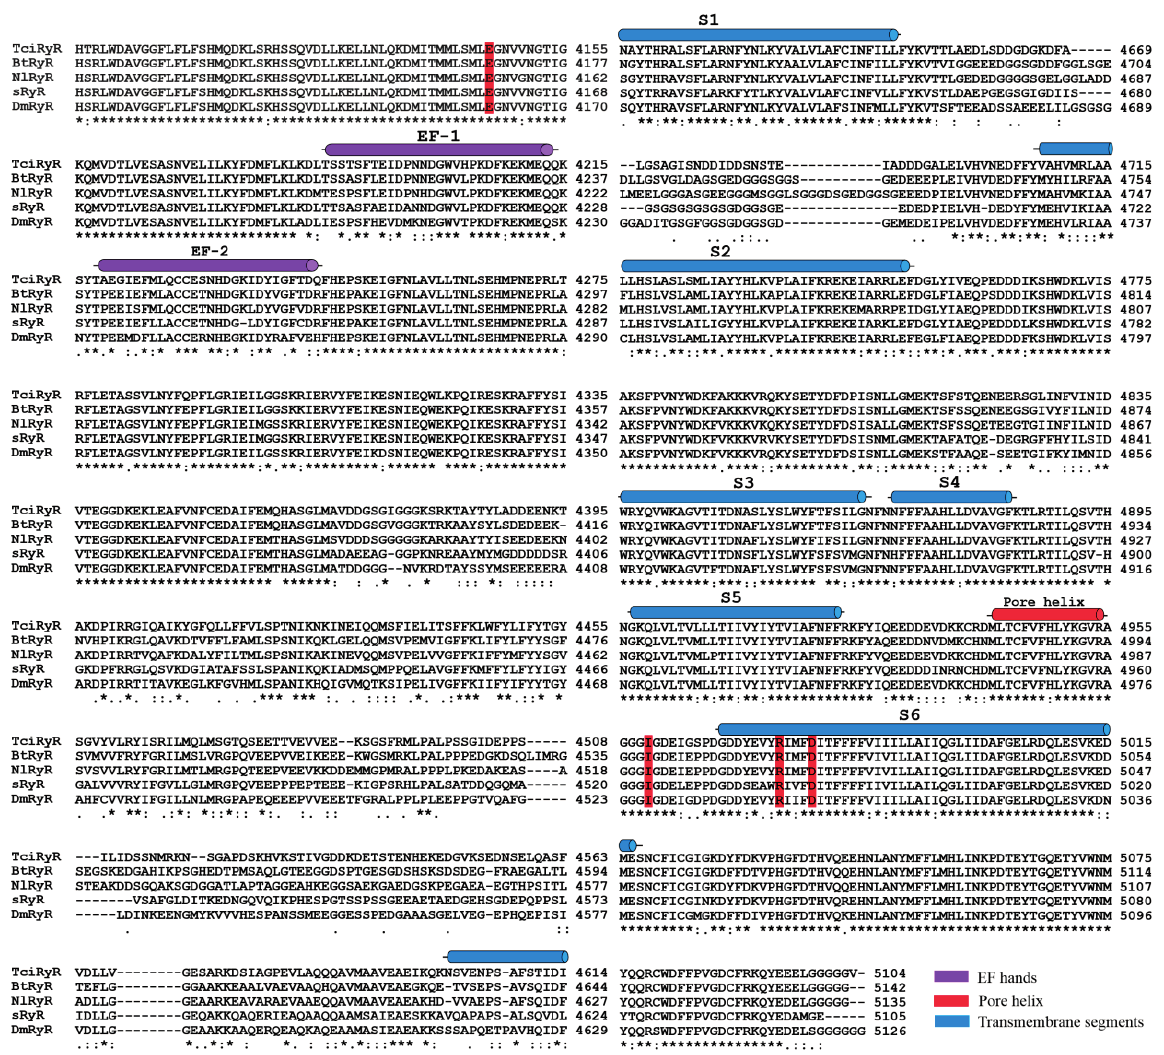
Figure 3. Multiple sequence alignment of the C-terminal region of insect RyR homologs. Numbers on the right indicate the amino acid position in each protein. An asterisk ( * ) denotes identical residues; double dots (:) represent a conserved residue substitution; a single dot (.) shows partial conservation of the residue. Secondary structural elements are indicated above the sequence alignment including two putative EF-hand motifs (EF1 and EF2), six transmembrane segments (S1 to S6) and a Pore-helix [33]. Important residues we discussed in the text (E 4145 , I 4958 , R 4974 , D 4978 ) are shadowed in red. Abbreviations and GenBank entries for the RyR homologs are described in Table